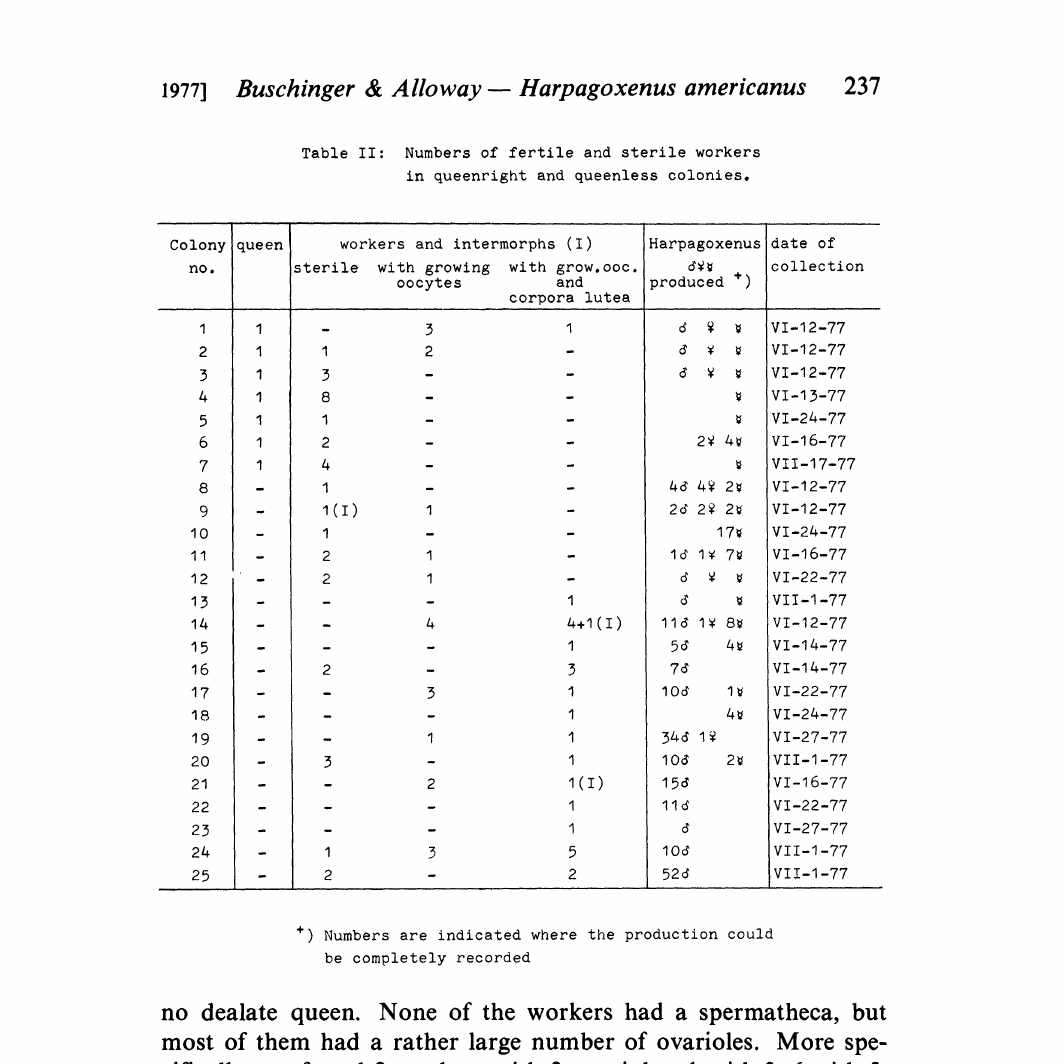
Table II: Numbers of fertile and sterile workers in queenright and queenless colonies.